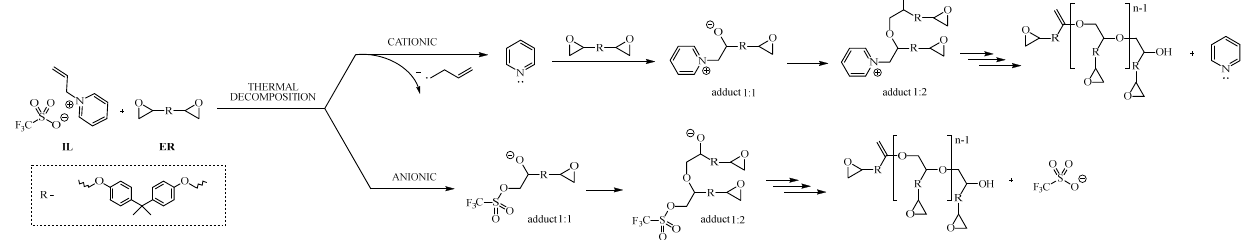
Figure 5. Proposed pathway of epoxy resin polymerization, initiated by triflate-based